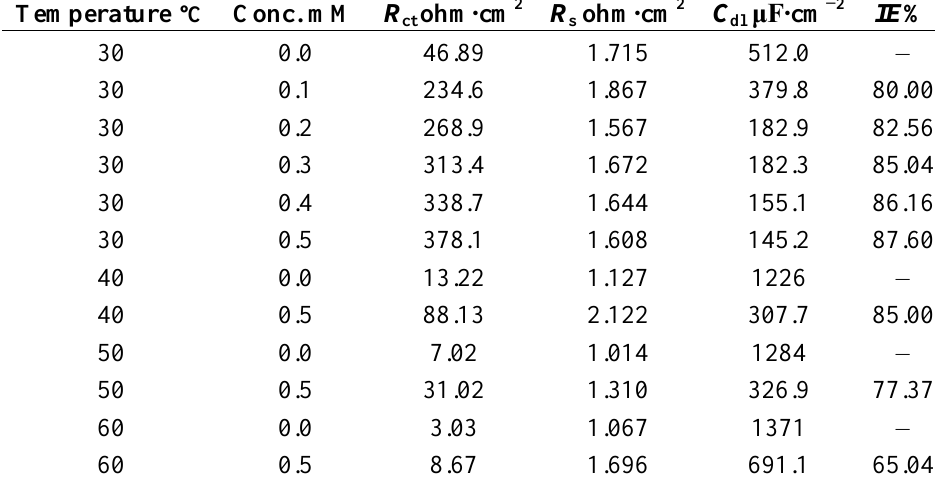
Table 2. Impedance data for mild steel in 1.0 M HCl for various PBB concentrations at different